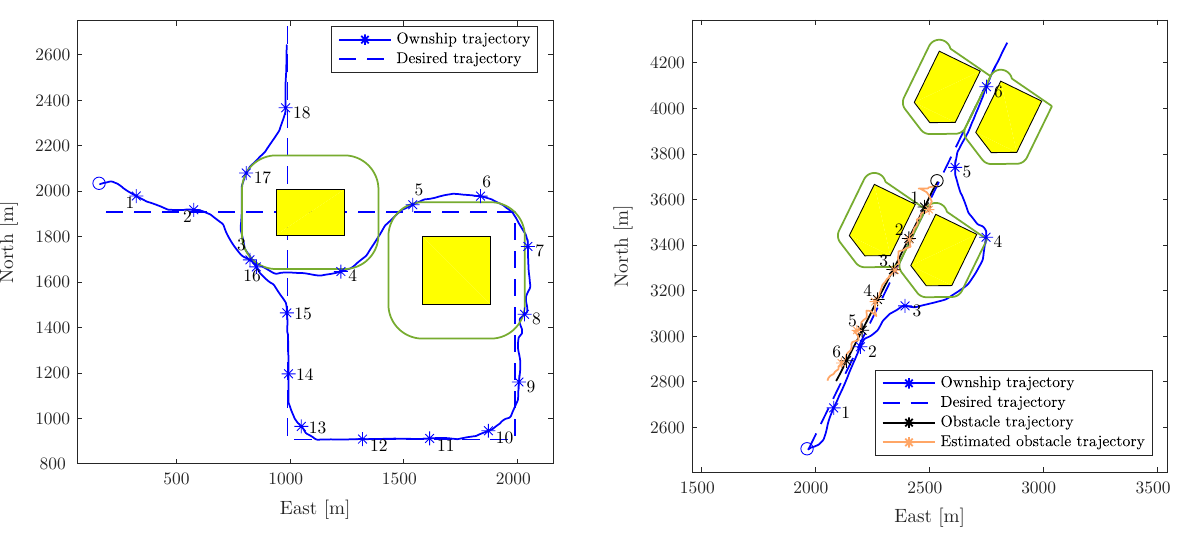
Figure 11: Scenario 2: Head-on situation. The desired tra- jectory passes through a narrow channel, which is blocked by the OSD1. The circles denote the initial positions, while the numbers and asterisks mark each 60 s of the experiment. The yellow patches show the static obstacles, while the dark green contour lines show the padding